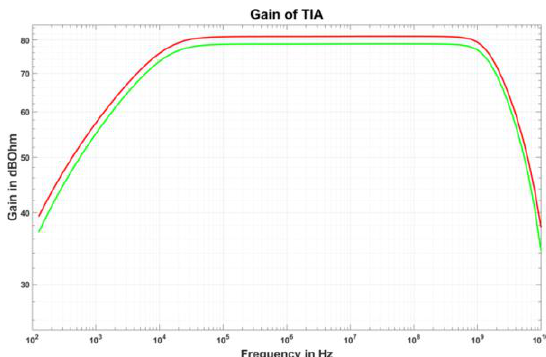
Fig. 5. Simulation results for the transimpedance gain before (red line) and after the output buffer (green line).